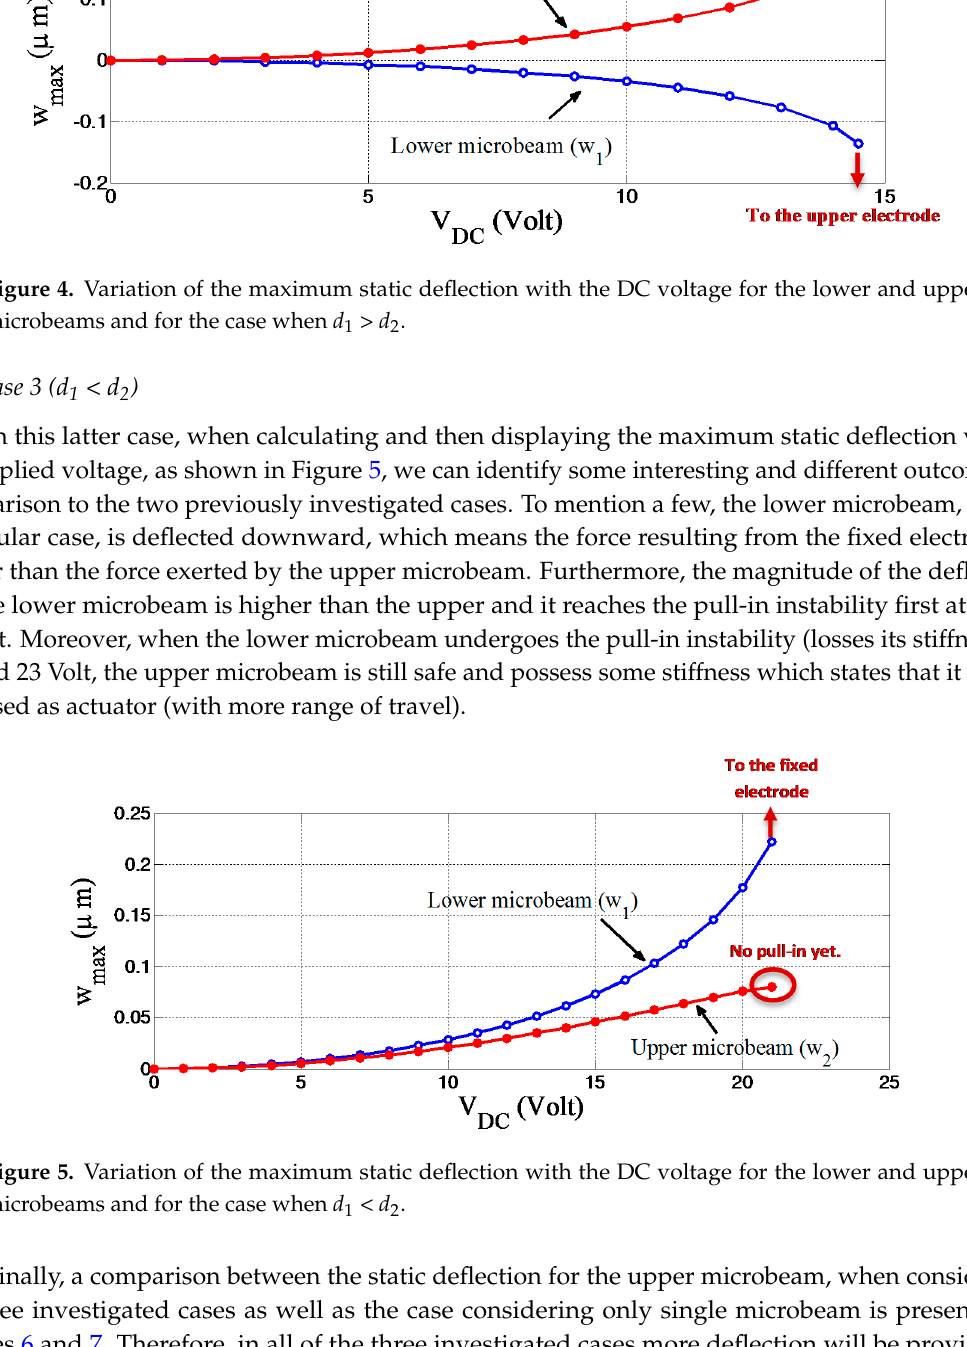
( d ) Figure 7. Comparison between the static profiles of ( a ) the single-microbeam configuration at V DC = 23 Volt with the double microbeam configuration just before the pull-in voltage for the case of: ( b ) d 1 = d 2 ; ( c ) d 1 > d 2 ; ( d ) d 1 < d 2 (Note: the length (L) in the above sketches is not to the scale). 0 One microbeam up to pull in voltage around 236 Volt